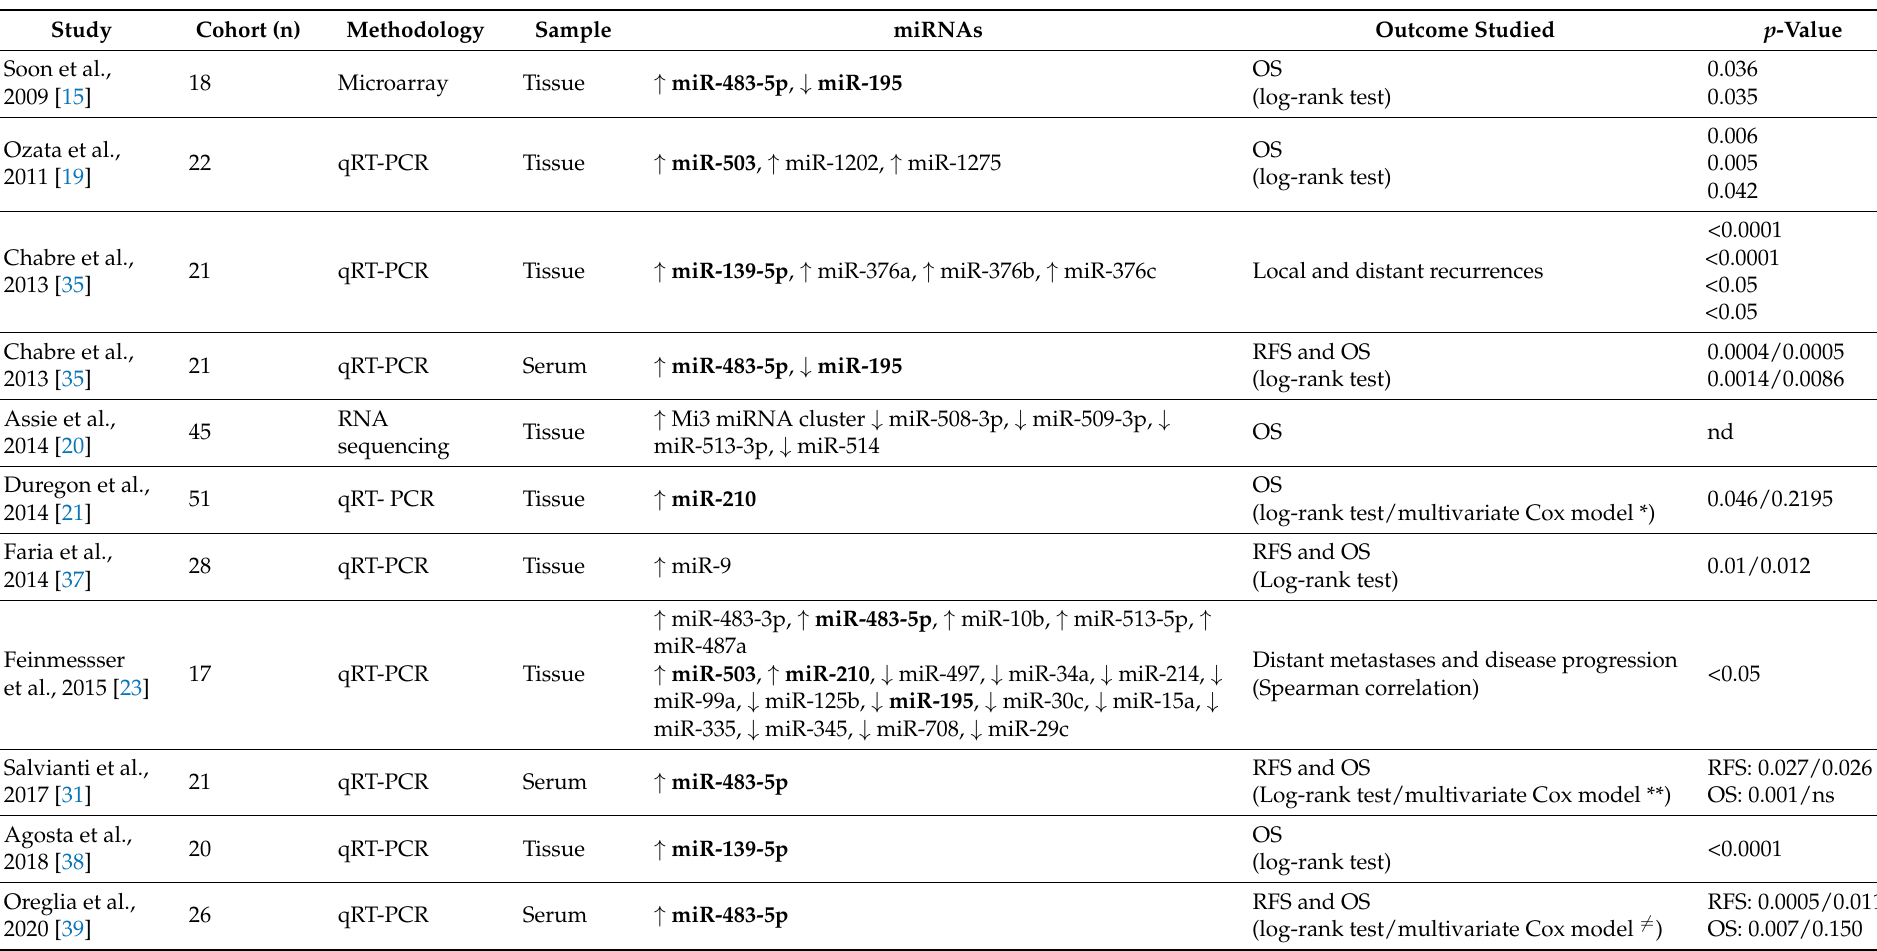
Table 2. miRNAs as prognostic biomarkers in